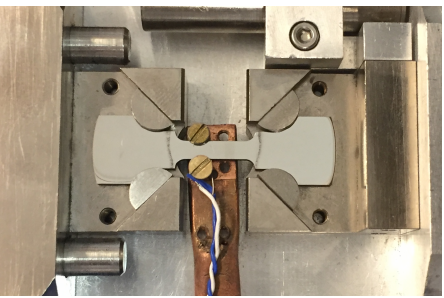
Figure 3. Cold finger attached to the specimen with a thermocouple placed between the screw-head and